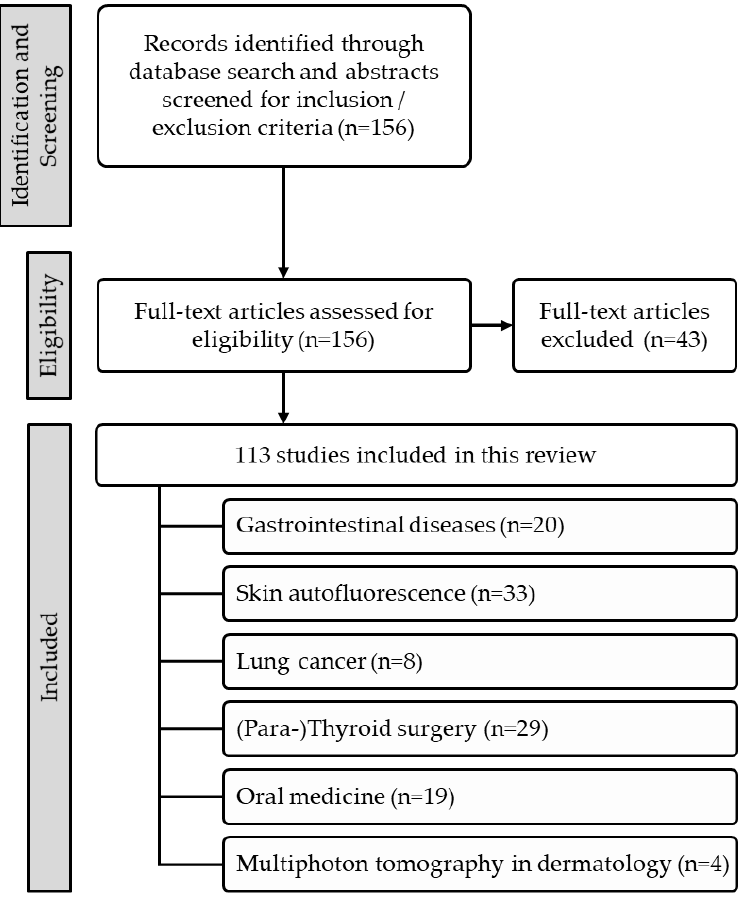
Figure 5. Flow diagram of study selection for this review.